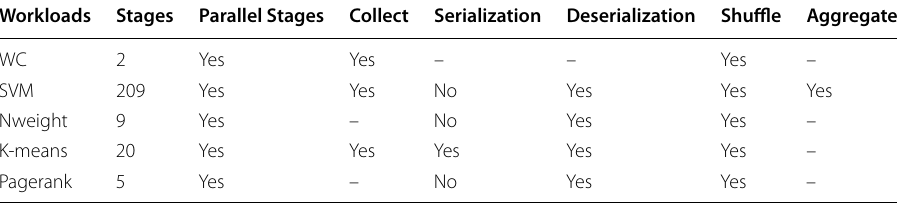
Table 5 Workload application